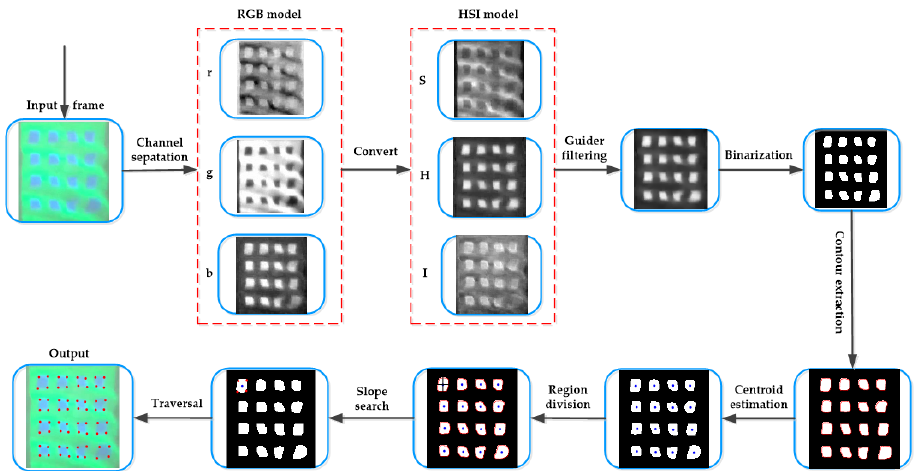
Figure 7. Framework of the feature extraction method in this paper.